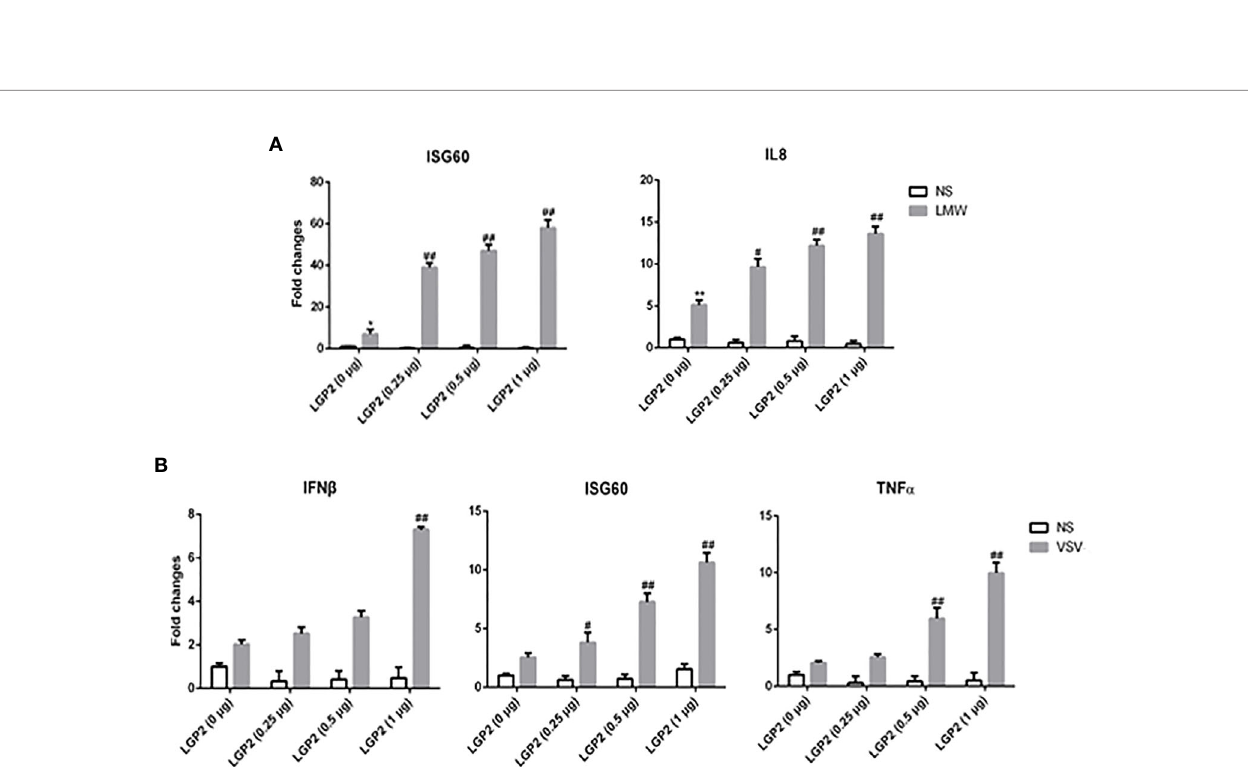
FIGURE 3 | LGP2 promoted the expression of downstream genes of RIG-I and MDA5 in PAMs after LMW poly I:C transfection and VSV infection. (A) PAMs grown in 24-well plates (3×10 5 cells/well) were transfected with LGP2 in different amounts (0, 0.25, 0.5, 1 m g) using Lipofectamine 3000. Twenty-four hours post transfection, the cells were stimulated with LMW poly I:C transfection (1 m g/ml) for 8h. Then the cells were analyzed by RT-qPCR for downstream gene expressions as indicated. (B) PAMs grown in 24-well plates were transfected as in (A) . The cells were infected with 0.01 MOI VSV for 8h and analyzed by RT-qPCR. * p < 0.05, ** p < 0.01 vs mock transfection and NS controls. # p < 0.05, ## p < 0.01 vs mock transfection and stimulated